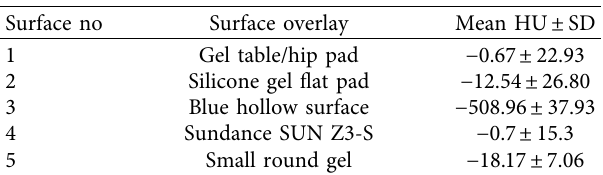
Table 5: The mean Hounsfield unit (HU) with standard deviation (SD) for the various surface